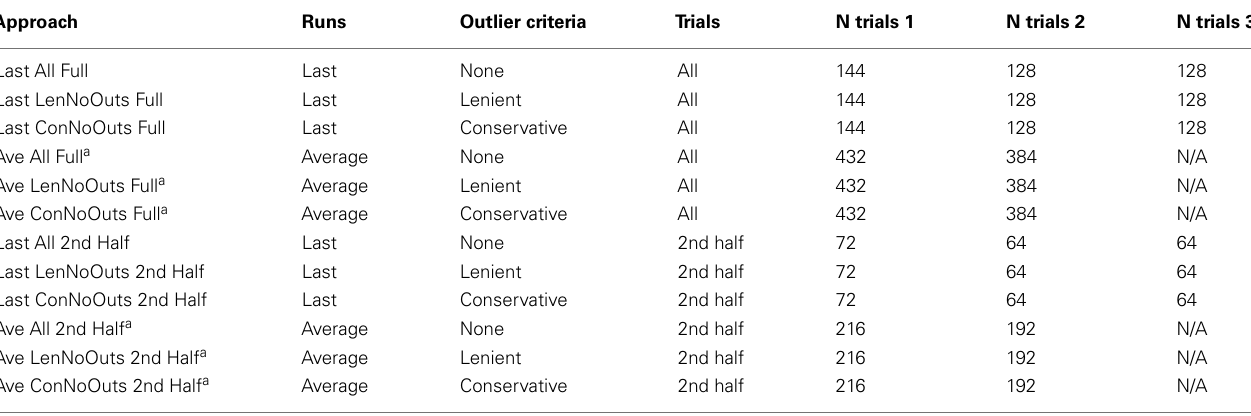
Table 1 |Twelve approaches to SSRT